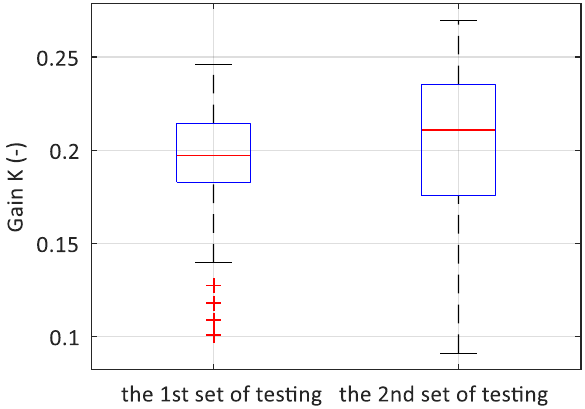
Figure 7. The box graphs for the parameter gain, K .